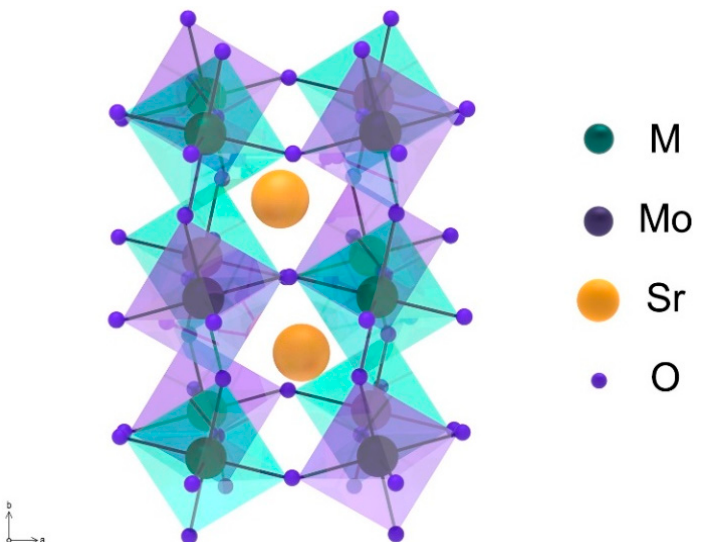
Figure 3. Structural phase transition of Sr 2 MMoO 6 from cubic to tetragonal lattice associated with the rotation angle of the MO 6 and MoO 6 octahedra. Reproduced with permission [32]. Copyright 2003, Elsevier.